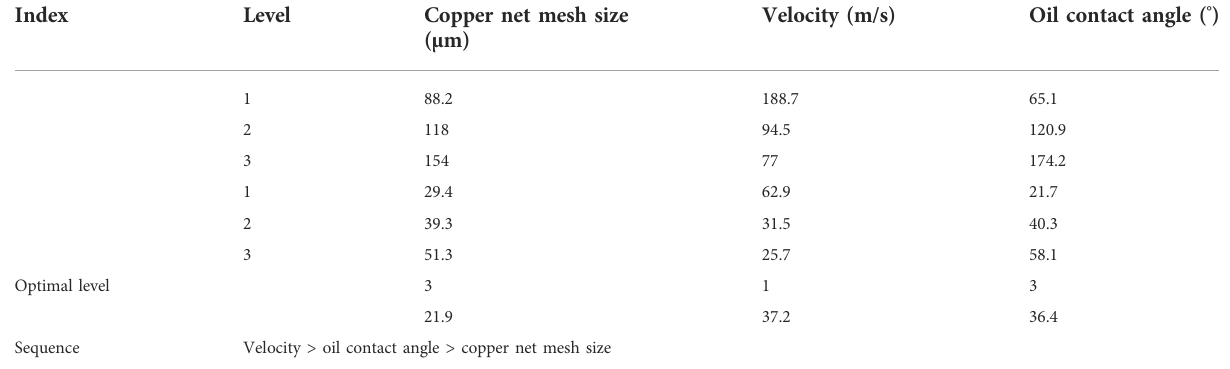
TABLE 4 Range analysis of orthogonal experimental